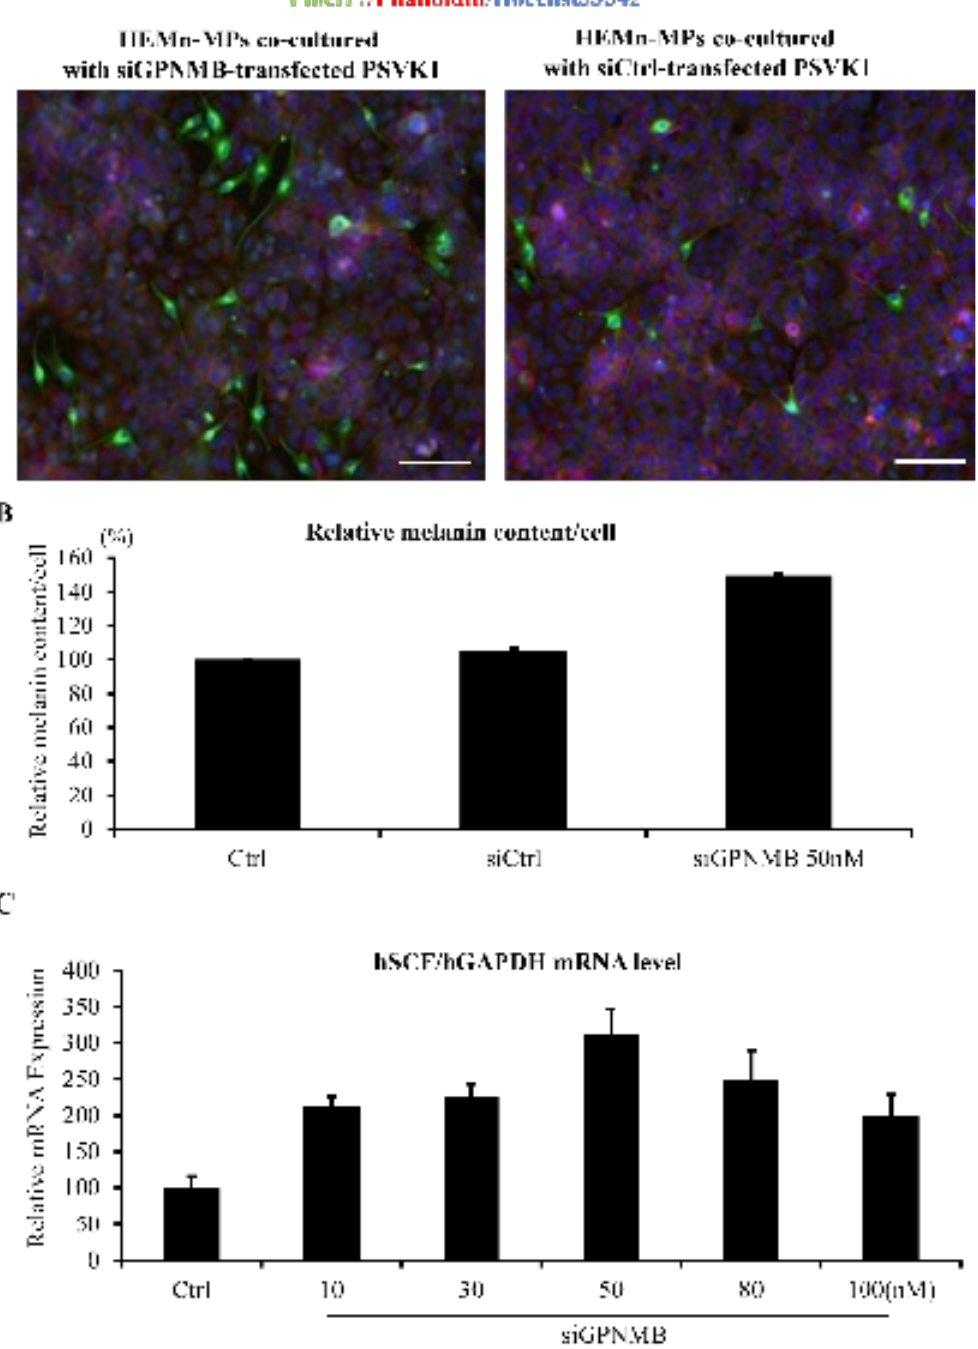
Figure 8. Effect of siRNA GPNMB introduced KC on melanocytes in a co-culture experiment. Human primary skin epidermal melanocytes (HEMn-MPs) were co-cultured with siGPNMB-transfected keratinocytes PSVK1 or siCtrl-transfected PSVK1. 24 h after co-culturing, cells were collected for RNA extraction, 5 days after co-culturing, cell images were collected for melanin content analyses or fixed for immunofluorescence staining. Melanocytes were stained with anti-Pmel17 antibody in green (A). Melanin content were measured in melanocytes without co-culture with keratinocytes (Ctrl), melanocytes co-cultured with siCtrl-transfected PSVK1 (siCtrl), and melanocytes co-cultured with siGPNMB-transfected PSVK1 (siGPNMB) (B). mRNA expression level of SCF in siGPNMB-transfecetd PSVK1 were examined by real-time PCR (C). Scale bar: 100 μm